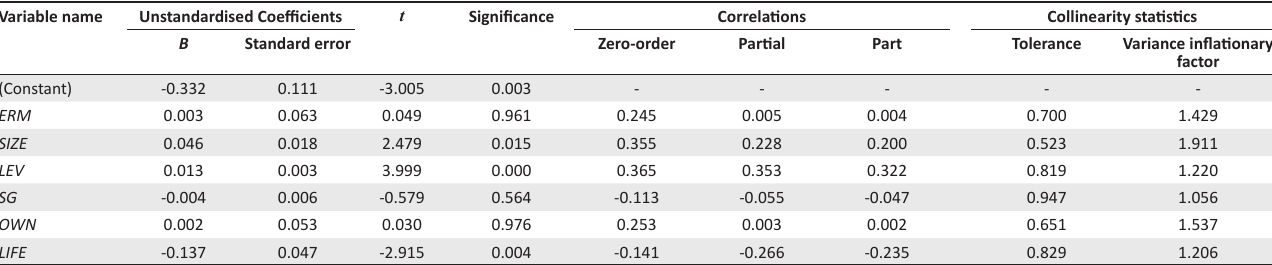
TABLE 5: Coefficients, correlations and collinearity statistics. Variable name